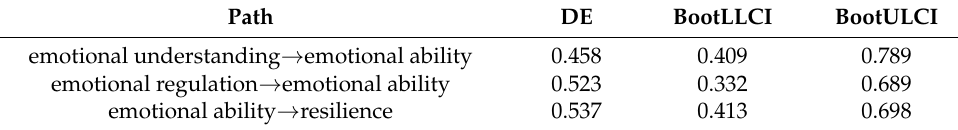
Table 9. Direct path effect. (DE, direct effect; there is no indirect effect; the table does not show IE.) Path